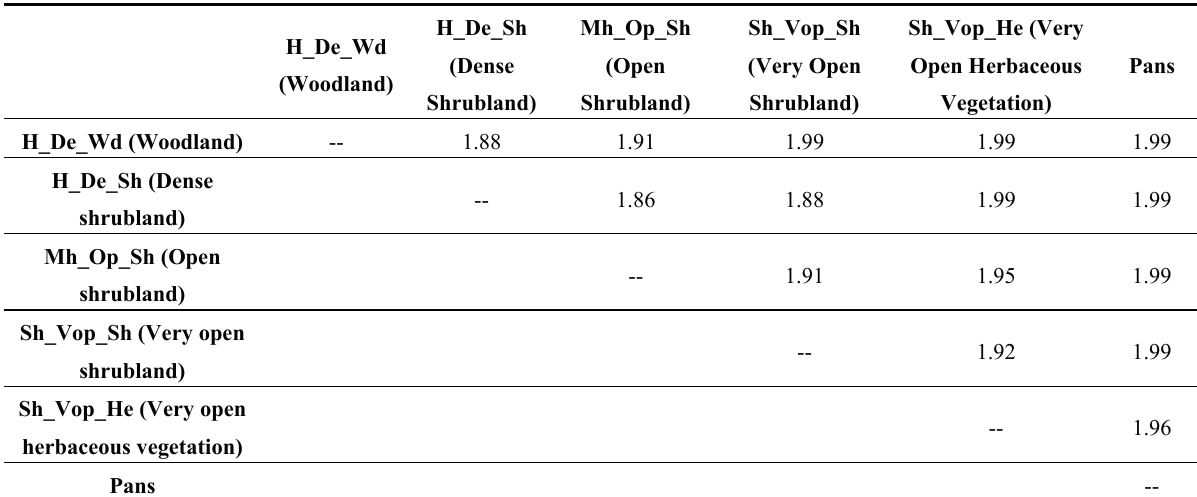
Table 1. Spectral separability between different vegetation morphology classes reported as Jeffreys-Matusita